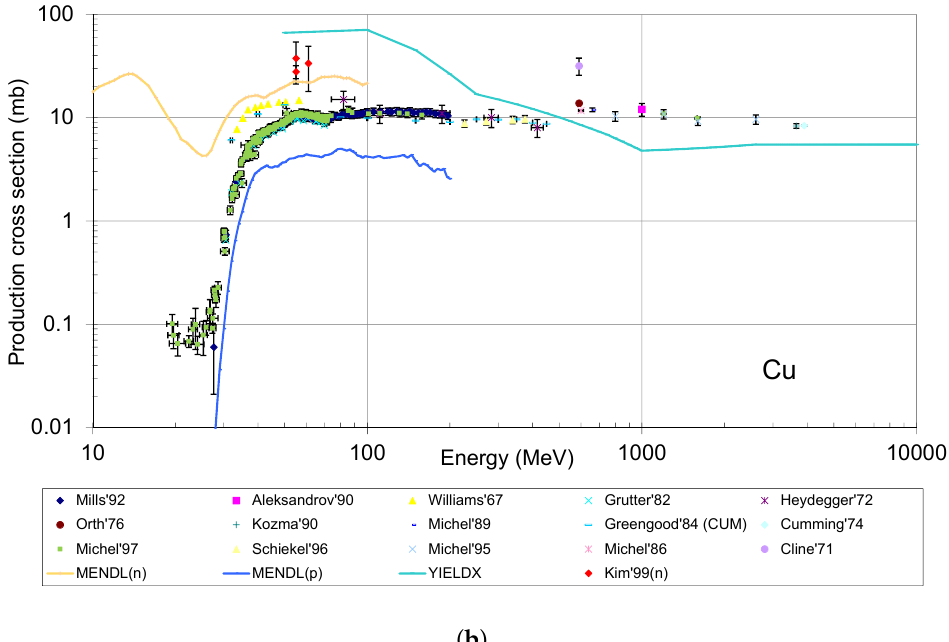
Figure 1. Compilation of excitation functions for the production of 60 Co by protons and neutrons in natural germanium ( top ) and in copper ( bottom ). Experimental data obtained from the EXFOR database are shown together with calculations using semiempirical formulae and MC